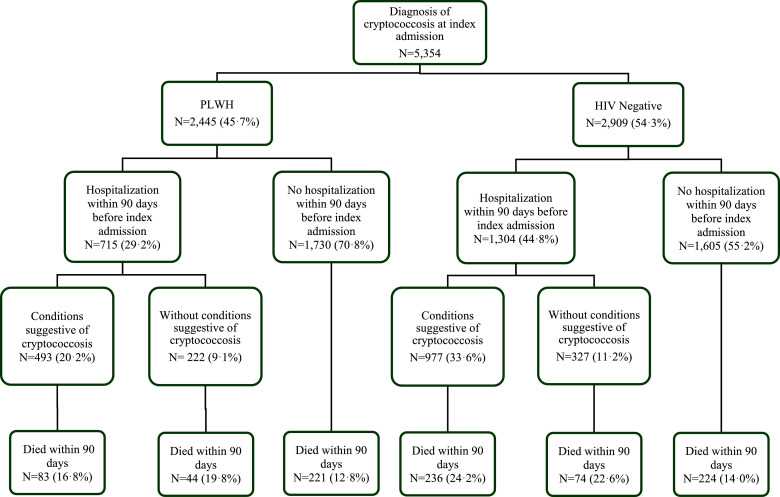
Flowchart for characterization of patients with cryptococcal disease stratified by HIV status. Potentially missed diagnoses for cryptococcal disease (CD) are common in both Persons Living with HIV (PLWH) and in HIV-negative populations. In the HIV-negative population, a potentially missed CD diagnosis is associated with higher mortality.